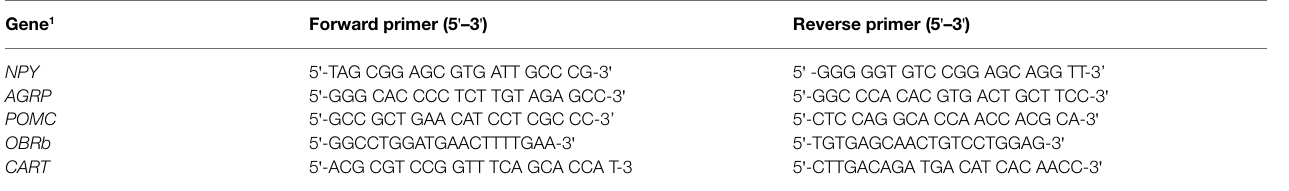
TABLE 1 | Sequences of primers used for real-time PCR quantification of gene